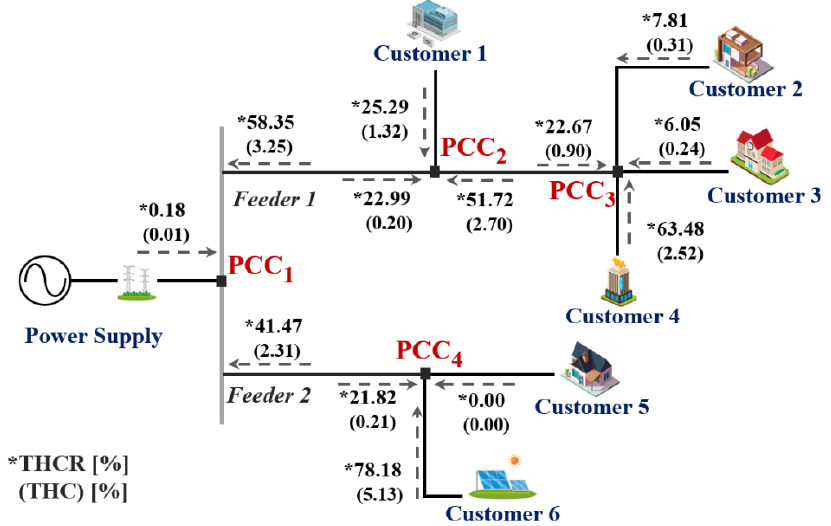
Figure 7. Example of a harmonic contribution diagram.